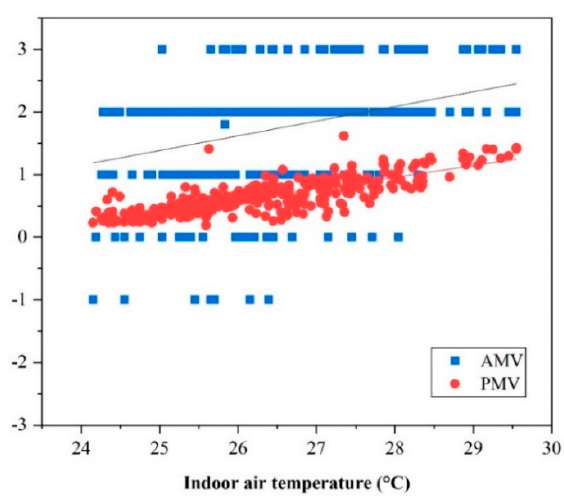
Figure 9. Comparison between PMV and AMV in relation to indoor air temperature.